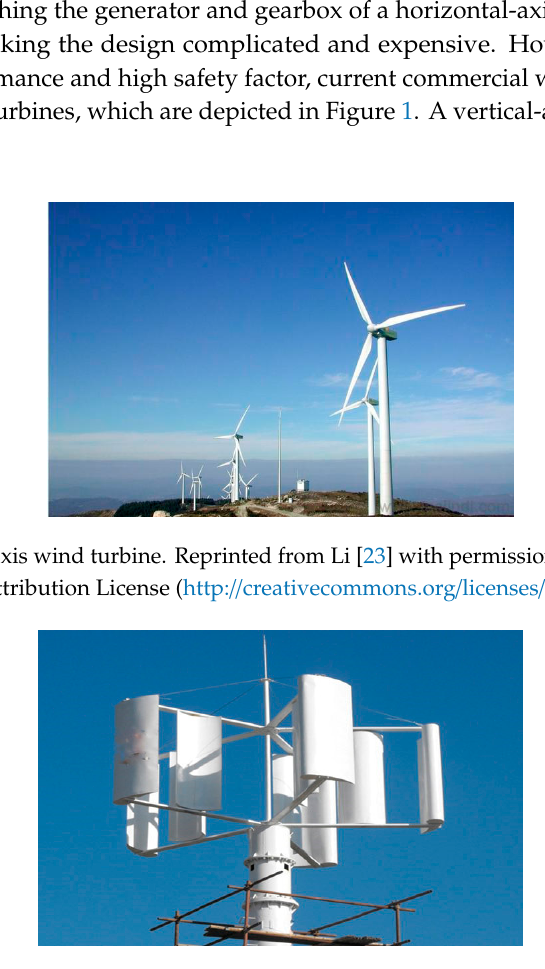
Figure 2. Vertical-axis wind turbine. Reprinted from Li [23] with permission under the terms of the